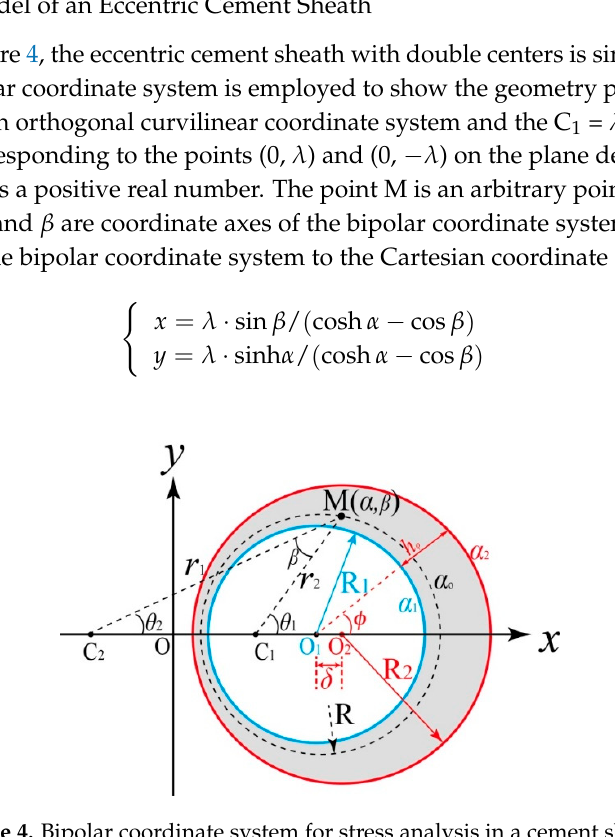
Figure 4. Bipolar coordinate system for stress analysis in a cement sheath.